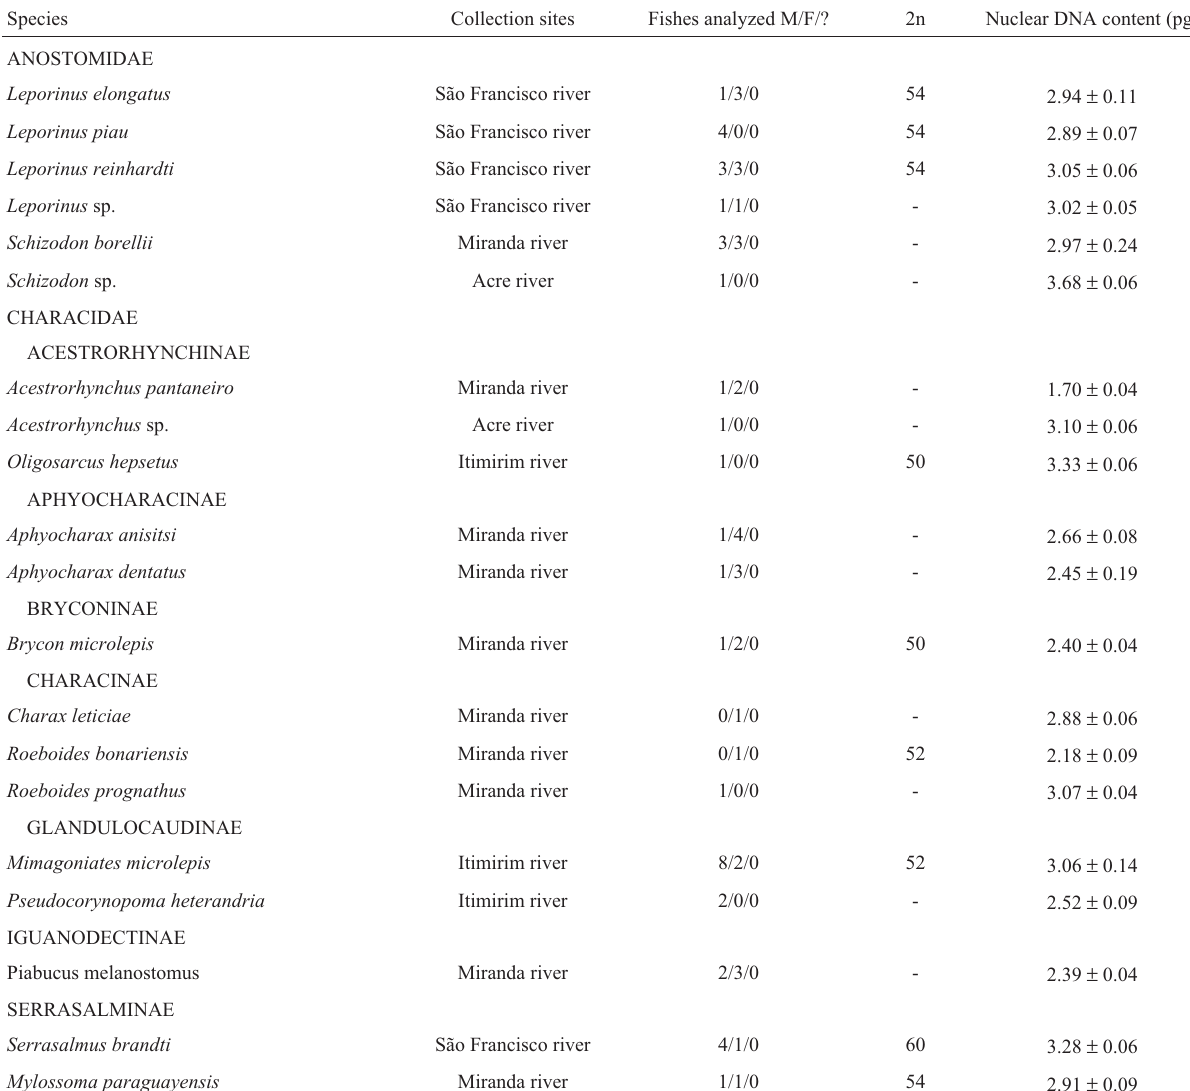
Table I - Diploid nuclear DNA content values, in picograms (pg), observed in the Characiformes species analyzed. Species Collection sites Fishes analyzed M/F/? 2n Nuclear DNA content